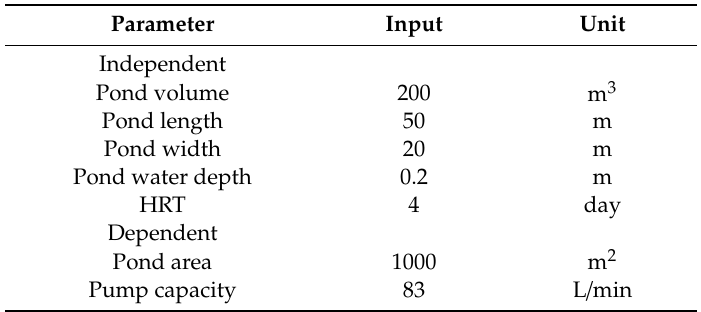
Table 4. Parameters set in the open raceway pond per 50 m 3 / day.